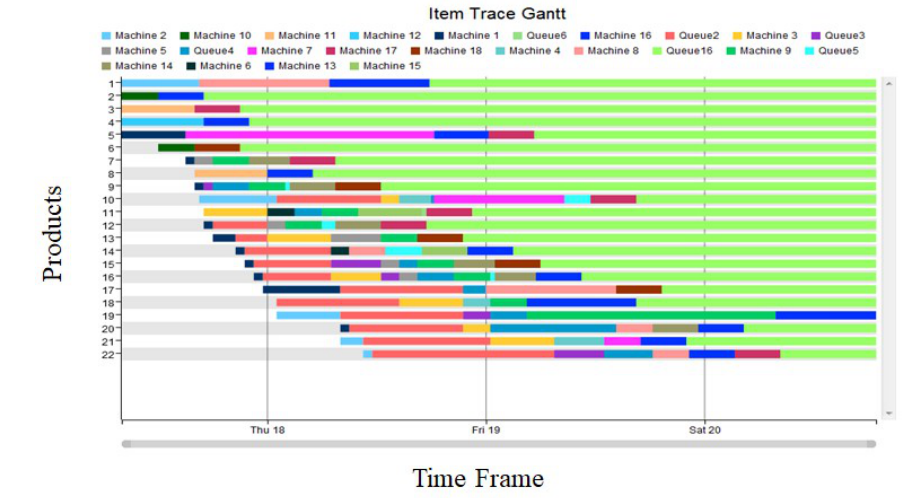
Figure 15. Gantt chart for production schedule using EDD as a dispatching rule.